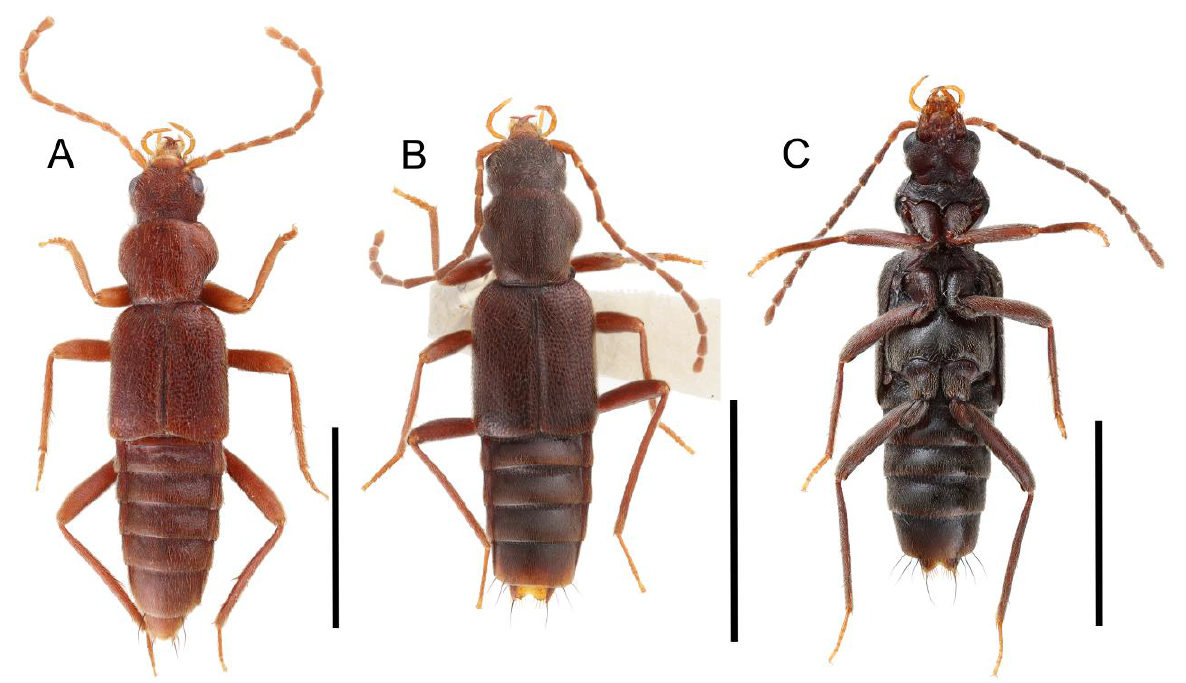
Figure 43. Habitus photographs of Deropini ( Derops ). ( A ) Derops divalis (Sanderson), dorsal view. ( B ) Derops longicornis Sharp, dorsal view. ( C ) Derops yaeyamanus Kishimoto, ventral view. Scale bars: 2.0 mm.